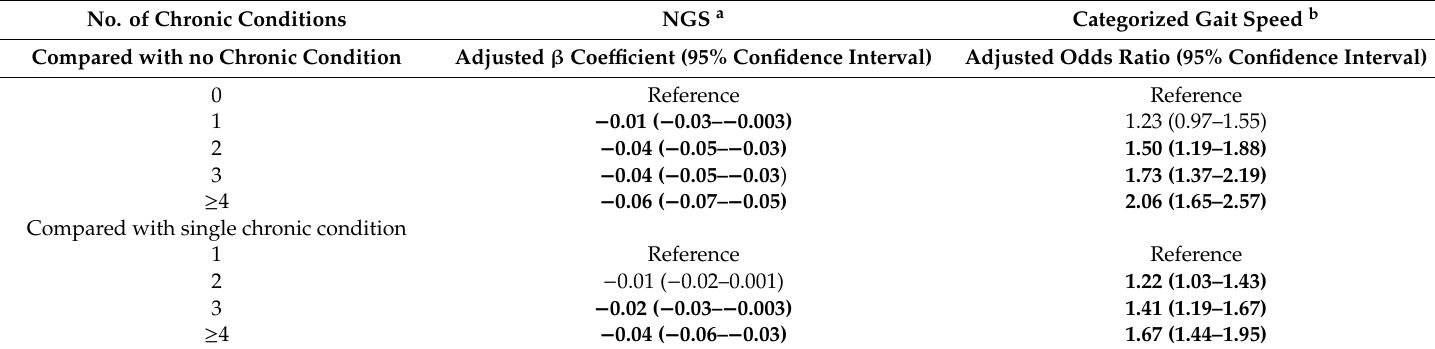
Table 3. Associations between multimorbidity and physical performance among older Chinese people ( N =